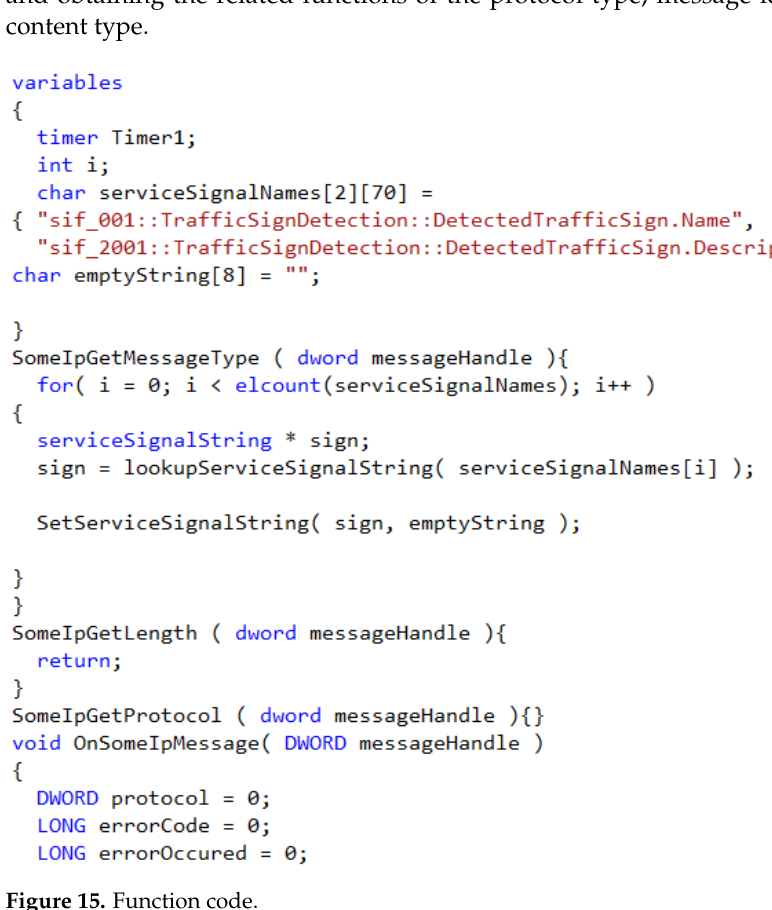
Figure 15. Function